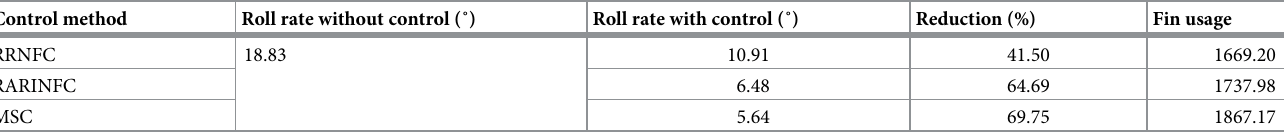
Table 5. Roll damping performance (experiment). Control